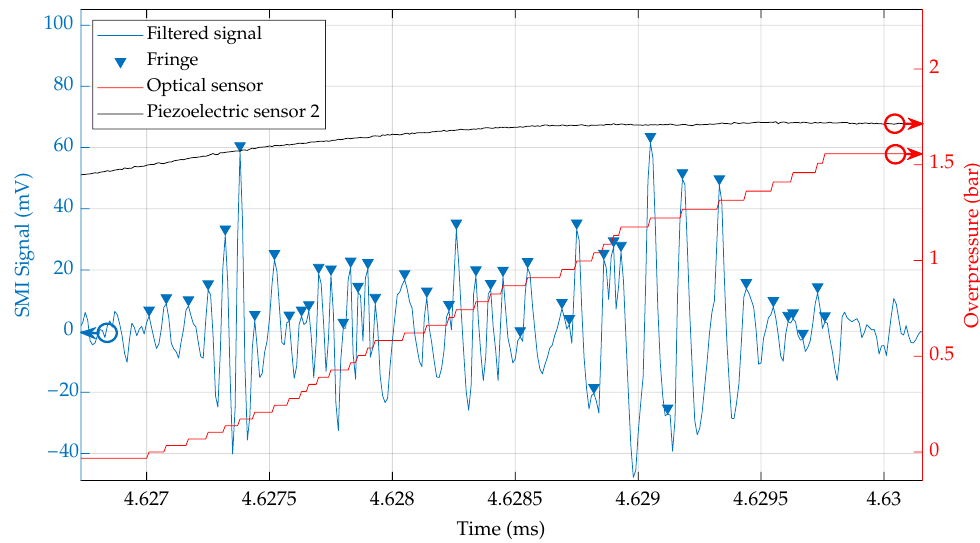
Figure 3. Zoom on the rise of the pressure step P 2 . Highlighting of fringe detections (blue triangles) for the reconstruction of the pressure signal (blue). The reference signal of the piezoelectric sensor 2 (black solid line) and the reconstructed pressure change (red solid line) are also displayed.